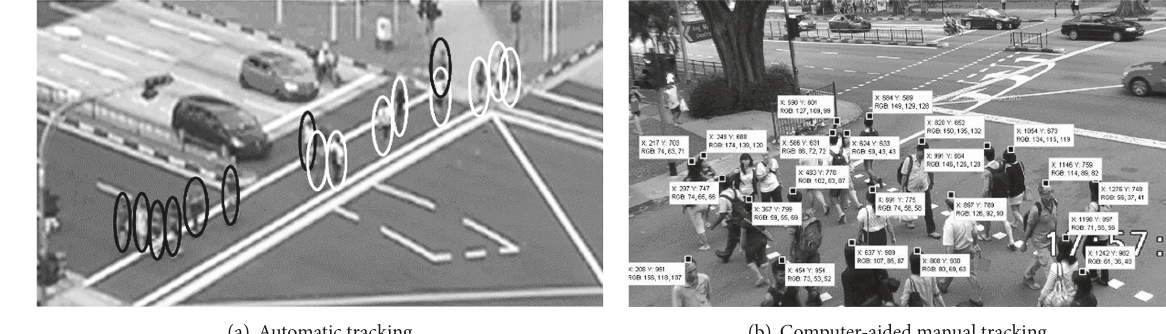
Figure 1: Automatic and manual pedestrian tracking methods.